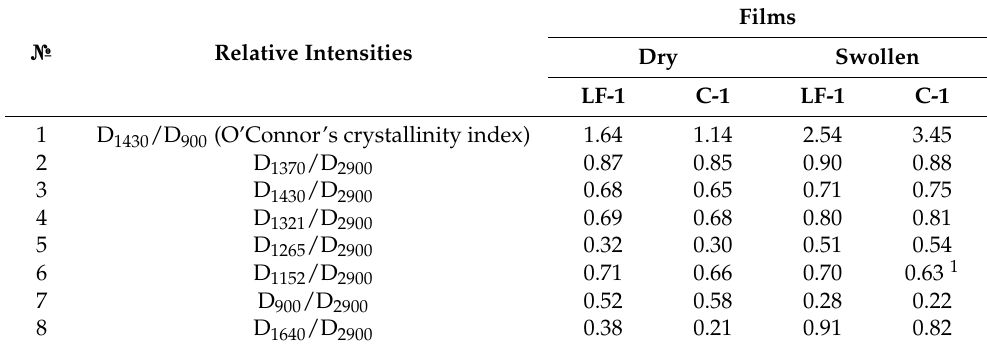
Table 1. Relative intensities of characteristic bands in the IR-spectra of dry LF-1 and C-1 cellulose films and indexes of ordering of swollen C-1 and LF-1 films based on relative intensities of characteristic bands in the IR